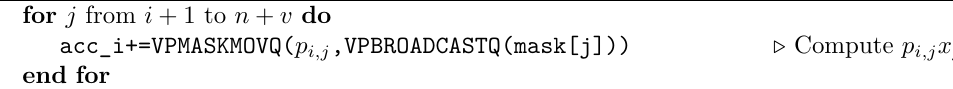
Algorithm 11 Improvement of Algorithm 10 with avx2 , VPMASKMOVQ and VPBROADCASTQ .